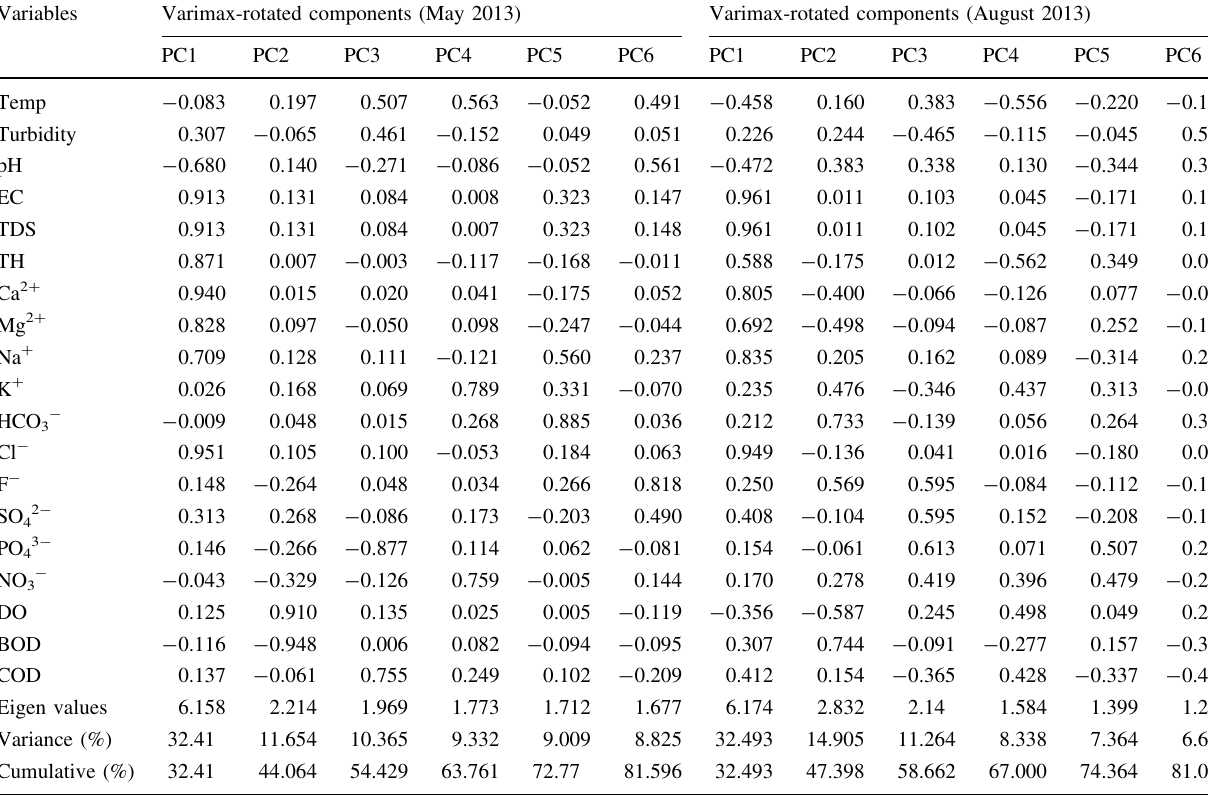
Fig. 8 a , b Scree plot of the eigenvalues of PCA (May 2013–August 2013) Table 6 Varimax-rotated factor loadings of groundwater quality parameters Variables Varimax-rotated components (May 2013) Varimax-rotated components (August